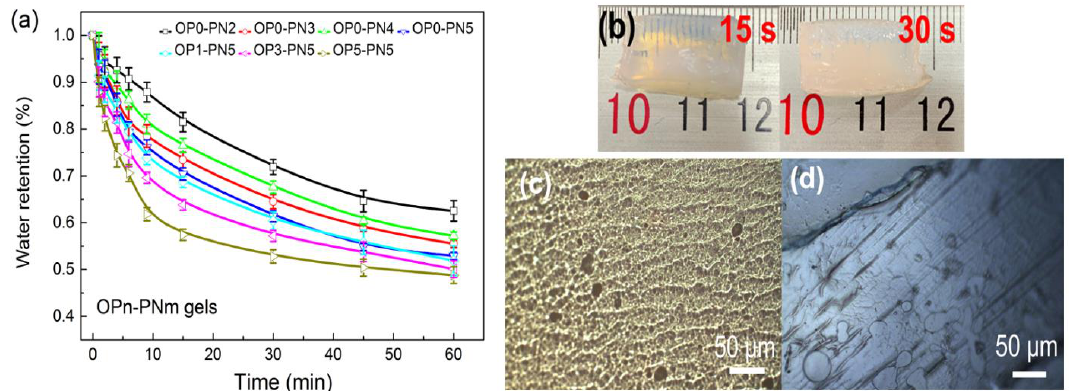
Figure 7. Deswelling properties of OPn-PNm gels: ( a ) water retention of OPn-PNm gels as a function of time in 50 °C water; ( b ) photo of OP5-PN5 gels after being immersed in 50 °C water for 15 s and 30 s; ( c ) optical microscopy (OM) image of OP5-PN5 gel surface in deswelling process; ( d ) OM image of OP0-PN5 gel surface in deswelling process.